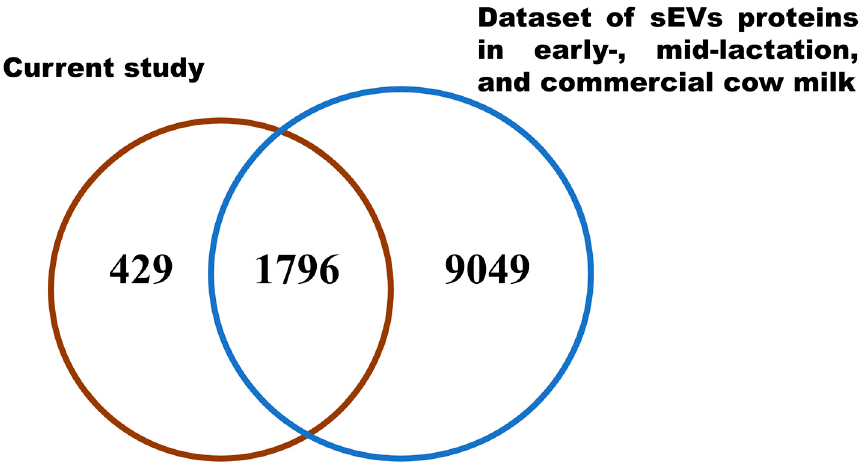
Figure 3. Comparative Vann diagram. Comparison of milk sEVs proteins in the current study with bovine milk sEVs bovine milk sEVs dataset.